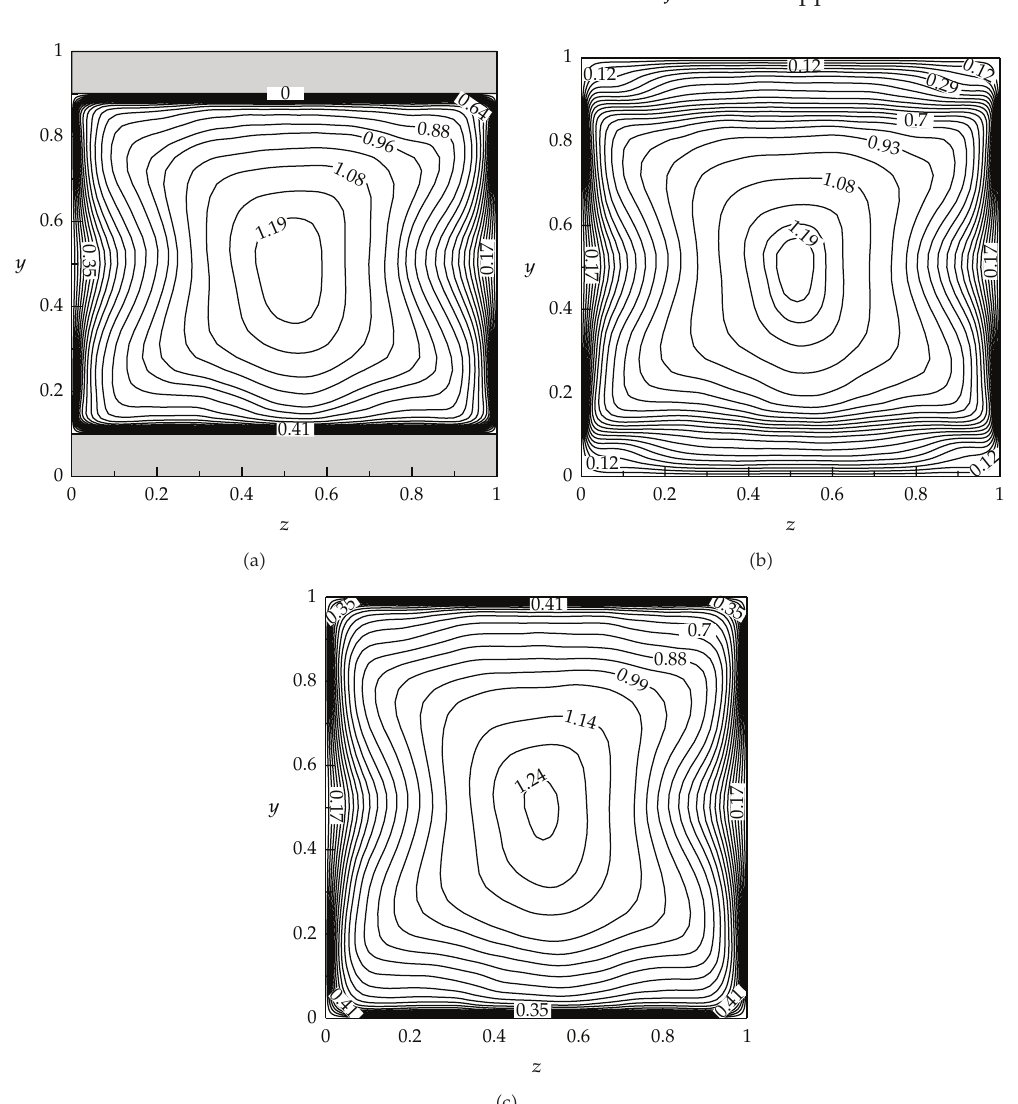
Figure 14: Time-averaged temperature contours (cid:2) locations same as in Figure 10 (cid:3) .